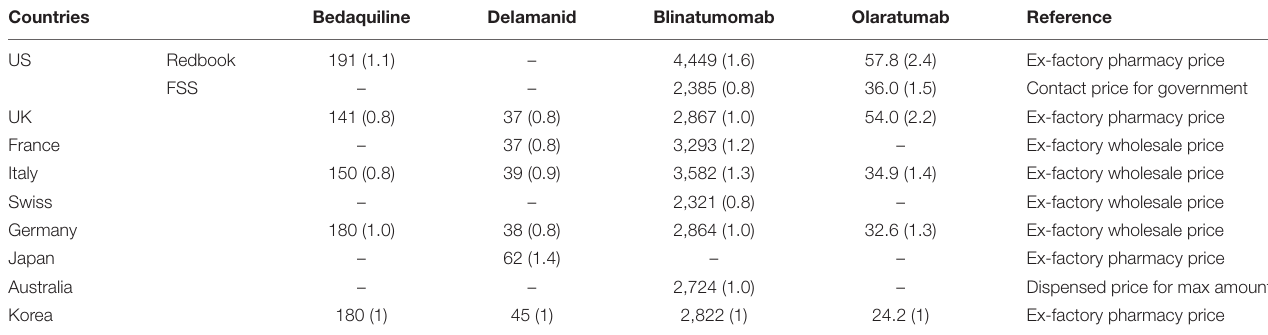
TABLE 2 | International price comparison of Korea’s reimbursement drug (USD